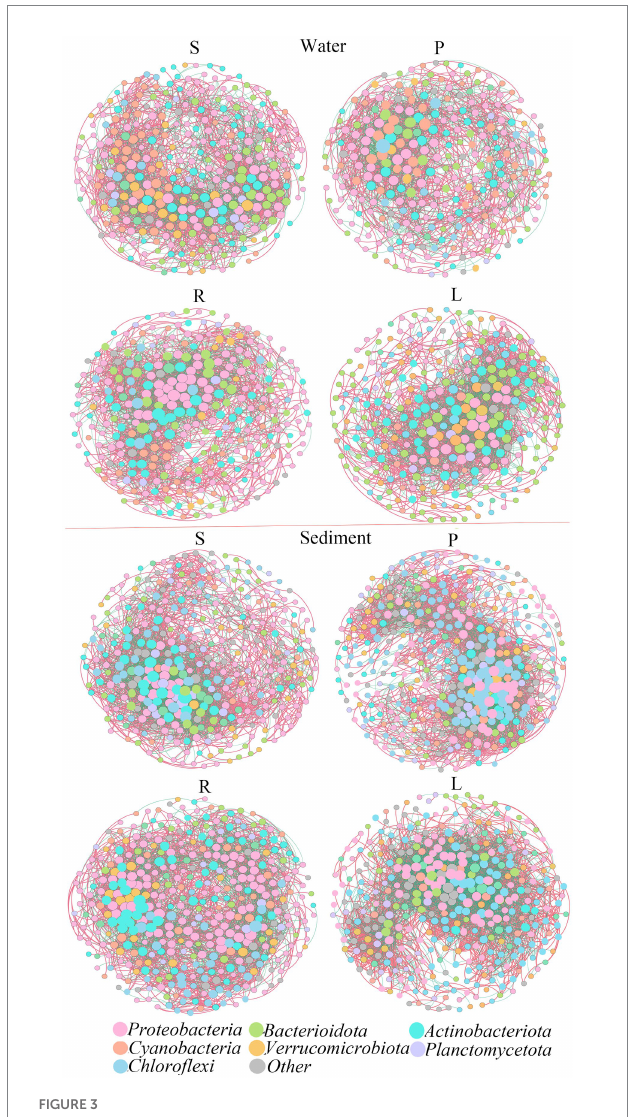
FIGURE 3 Co-occurrence networks and their topological properties of different bacterial communities in the water and